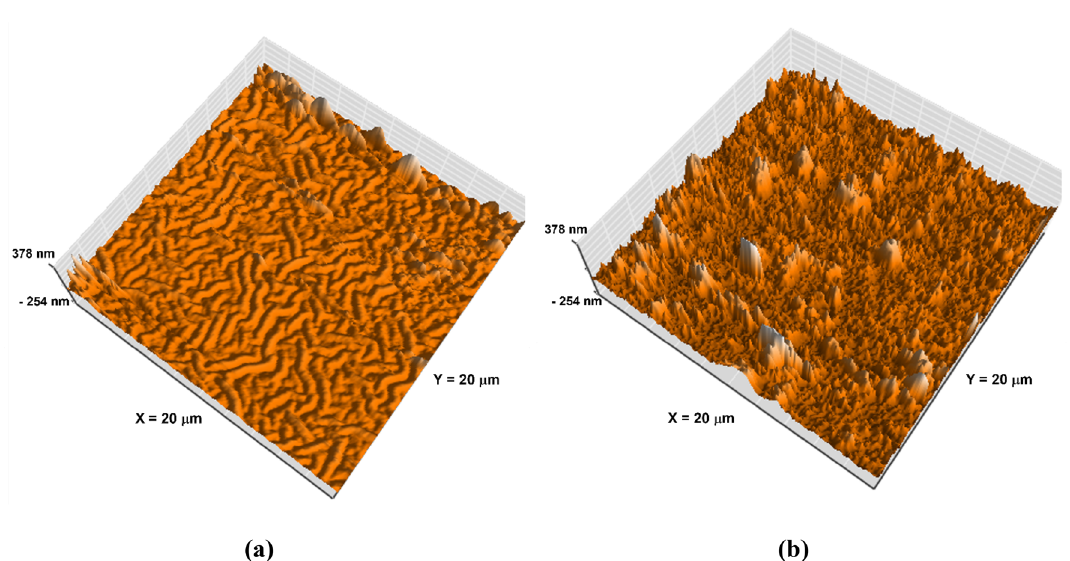
Figure 3. The 3D AFM images of the ZnO layer ( a ) annealed at 200 °C, and ( b ) annealed at 200 °C under applied 6